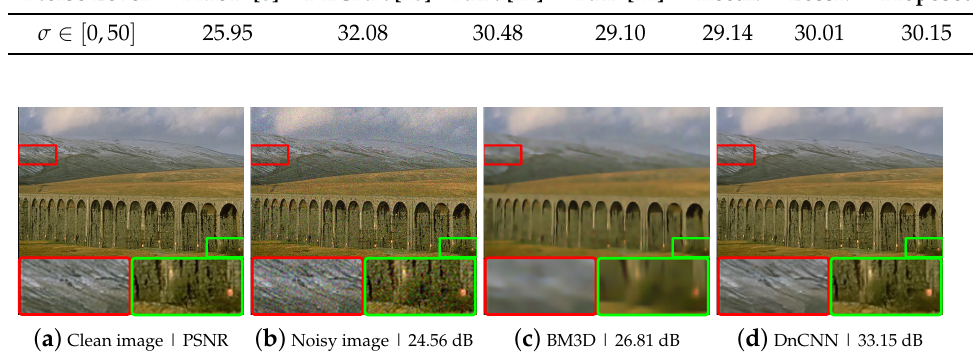
Table 2. Comparison of denoising performance for noisy image with various noise levels. Noise Level